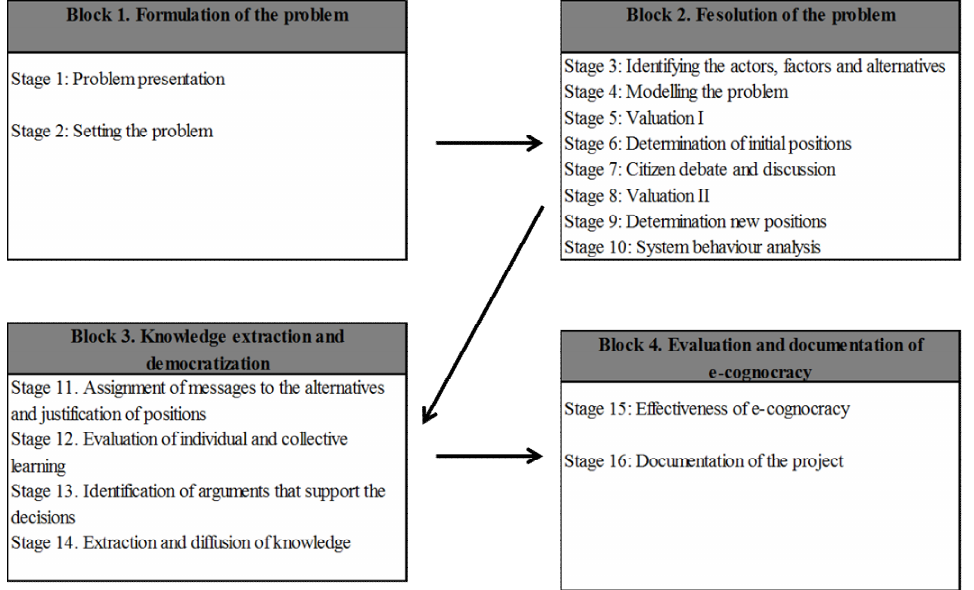
Figure 1. Blocks and stages of the e-Cognocracy methodology [16].